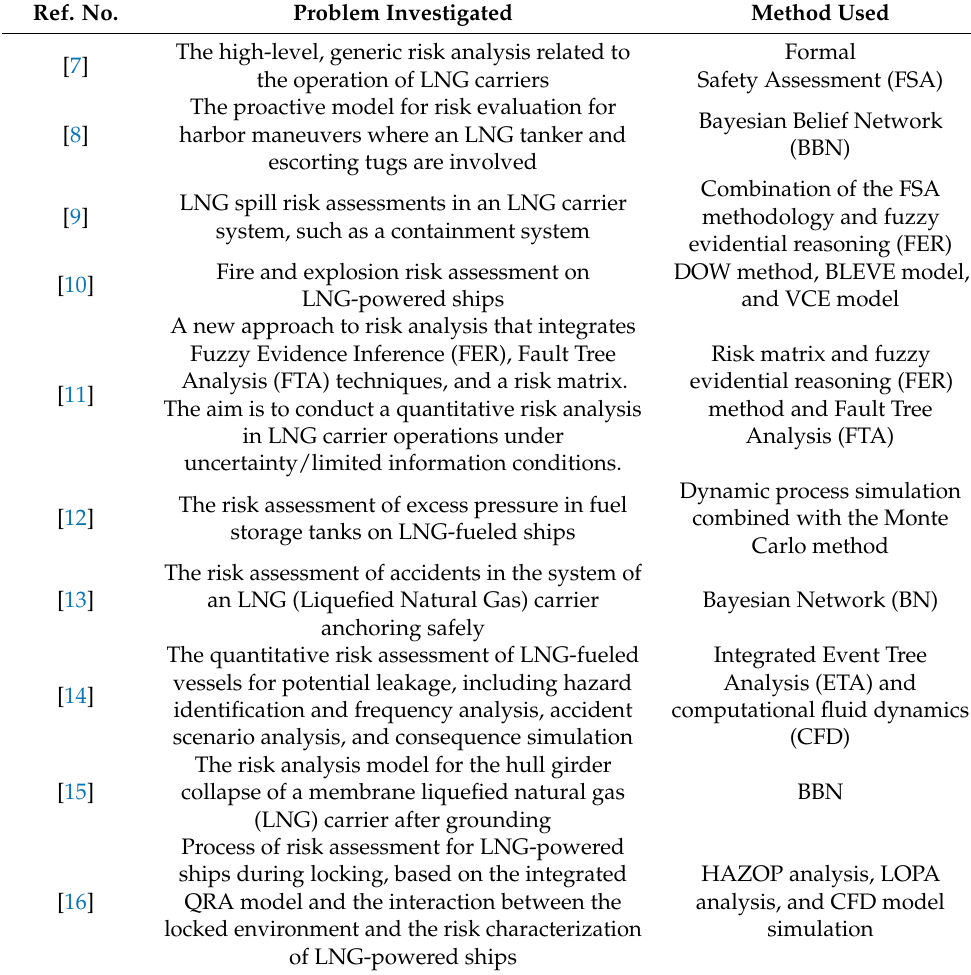
Table 1. Literature review for research Area 1—Risk related to LNG carriers and LNG-fueled ships. Ref. No.